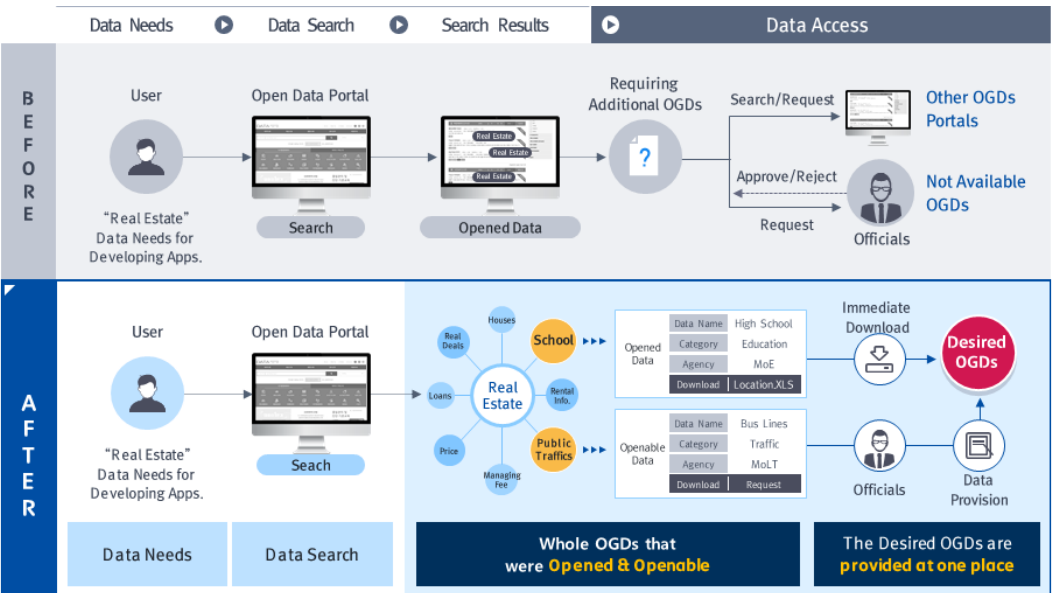
Figure 8. Before and After Comparison of Open-Data Platform Presence.